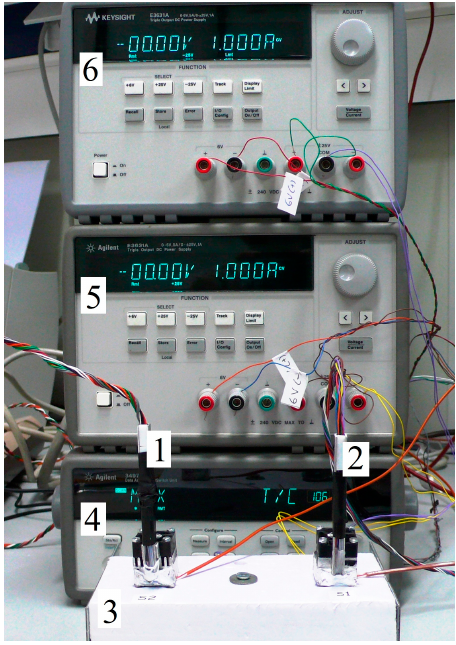
Figure 1. Minisensors ( 1 , 2 ) on its calibration base ( 3 ), data acquisition system ( 4 ) and the two power supplies ( 5 , 6 ).